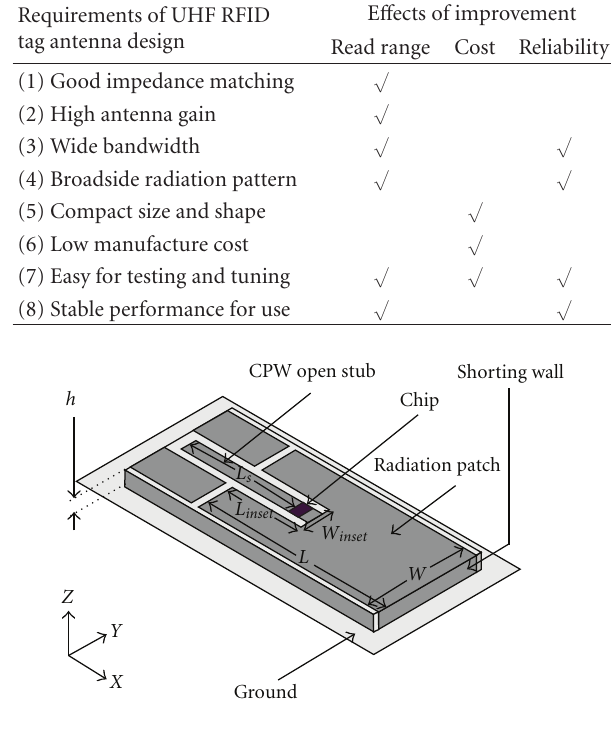
Figure 2: The open stub feed PIFA antenna structure. The dimen- sions of the radiation patch are ( L , W ) while the open stub has dimensions ( L s , W s ) and the height of the substrate (FR4) between the patch and the metallic surface is h